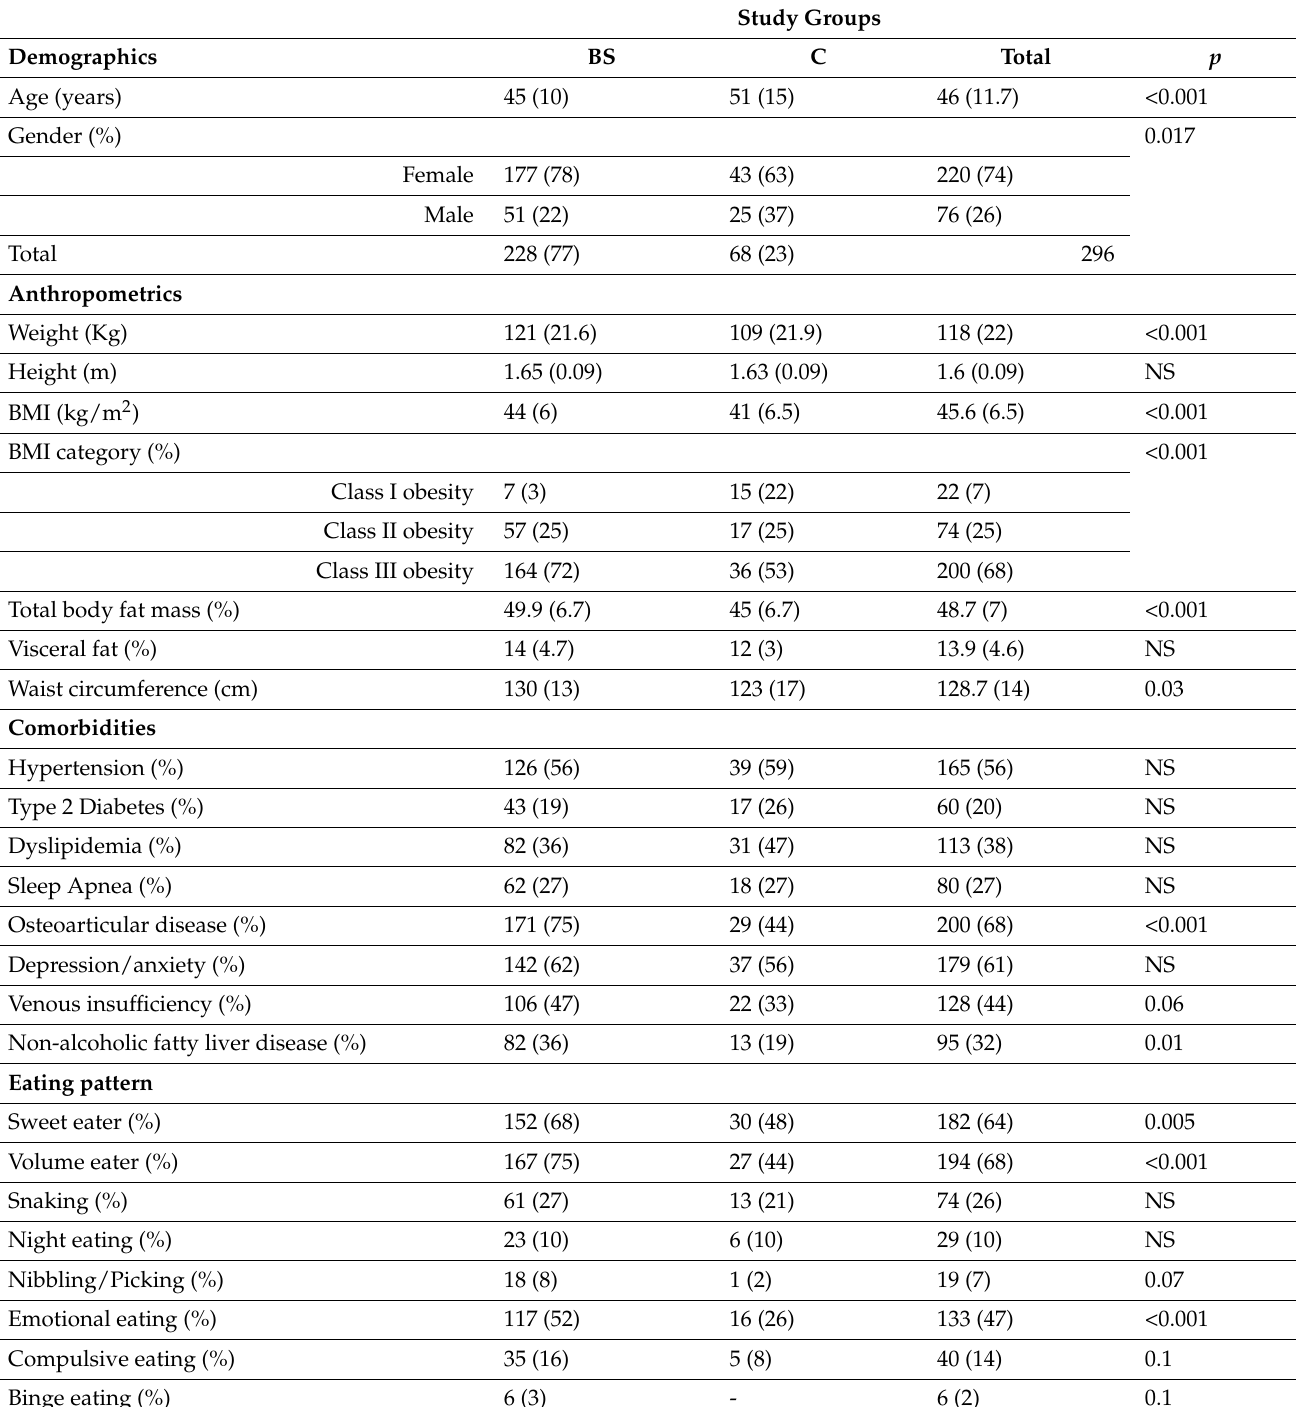
Table 1. Demographic, anthropometric, and clinical data regarding both the BS and C groups; NS =